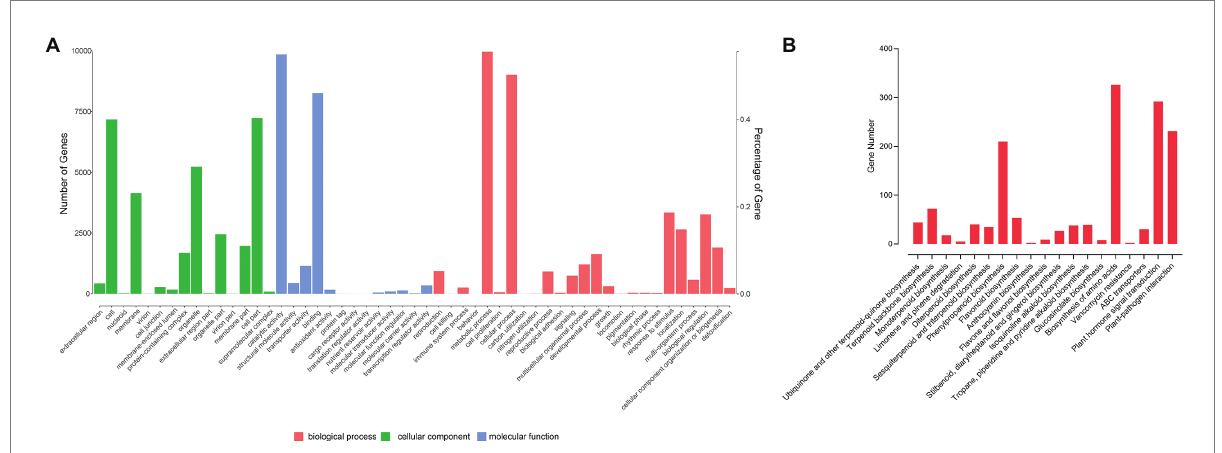
FIGURE 3 Gene annotation. (A) GO functional classification. (B) KEGG functional